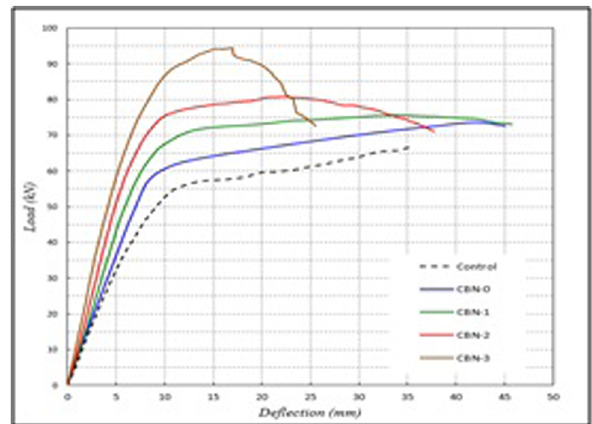
Figure 16: Load – de fl ection curve of all specimens and control